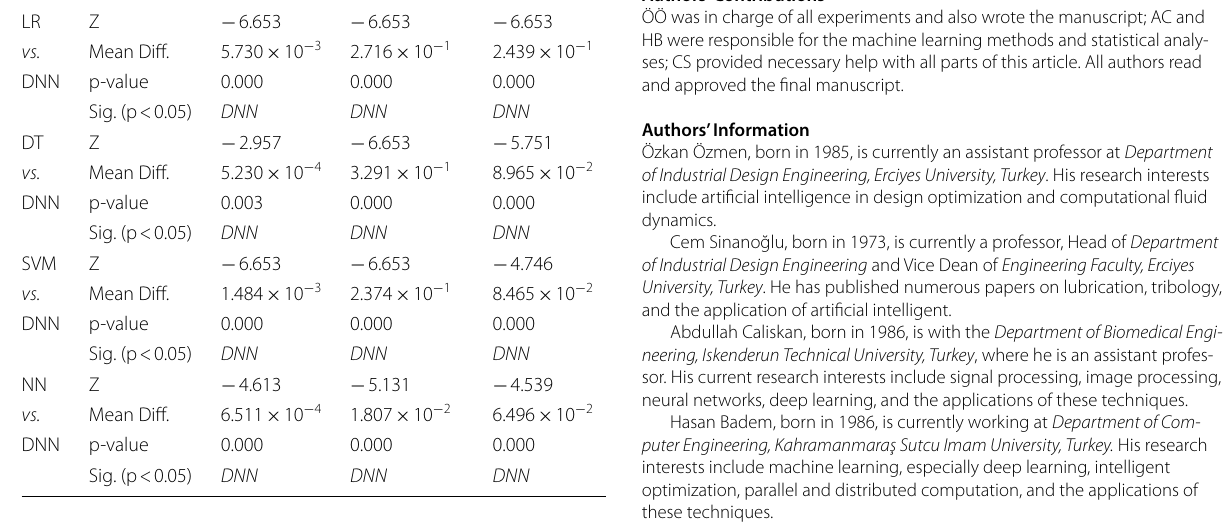
Table 5 Mann–Whitney U test results are listed to compare the MLMs in terms of slipper parameters